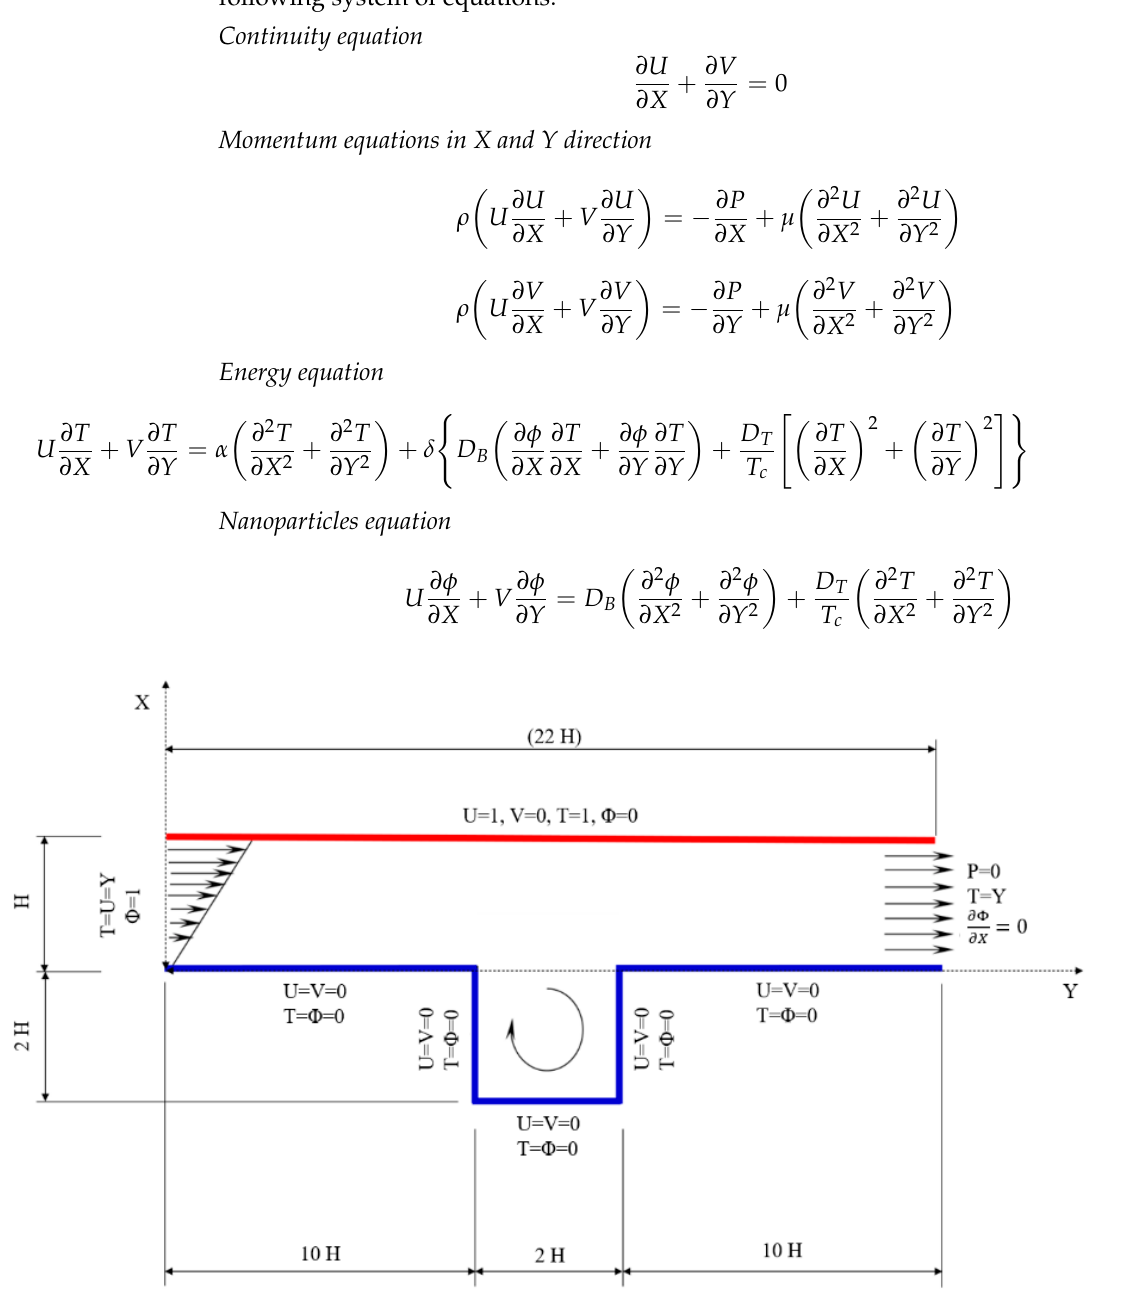
Figure 1. Domain and boundary